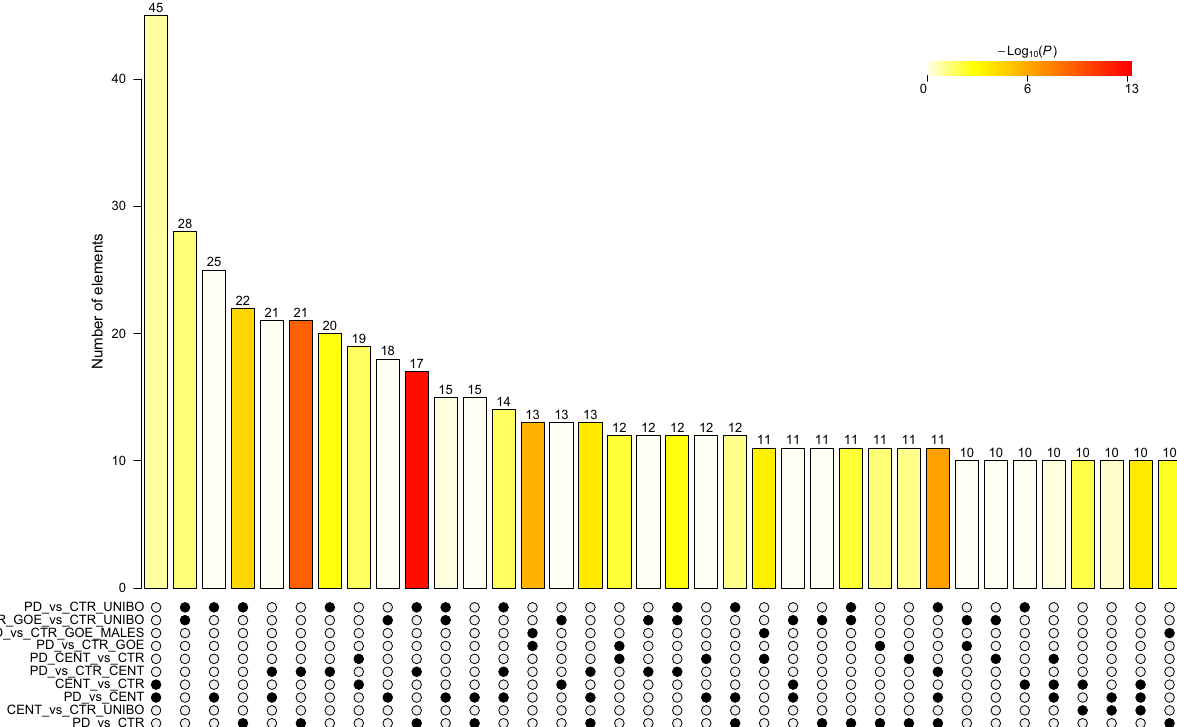
Figure 1. Intersection plot reporting the number of shared DEMs. The matrix at the bottom represents a table whose rows are the DESeq2 contrasts (names on the left and size on the right end), and whose columns represent the results of selected contrasts’ intersections (solid black circle). The sizes of each intersection is visually depicted by the bars color-coded by statistical significance (p-value), and sizes reported on top. The minimum number of shared DEMs in the plot is 10. The plot was created using the R package upset v. 1.4.0 48 (https:// cran.r- proje ct. org/ web/ packa ges/ UpSetR/ index. html), R software version